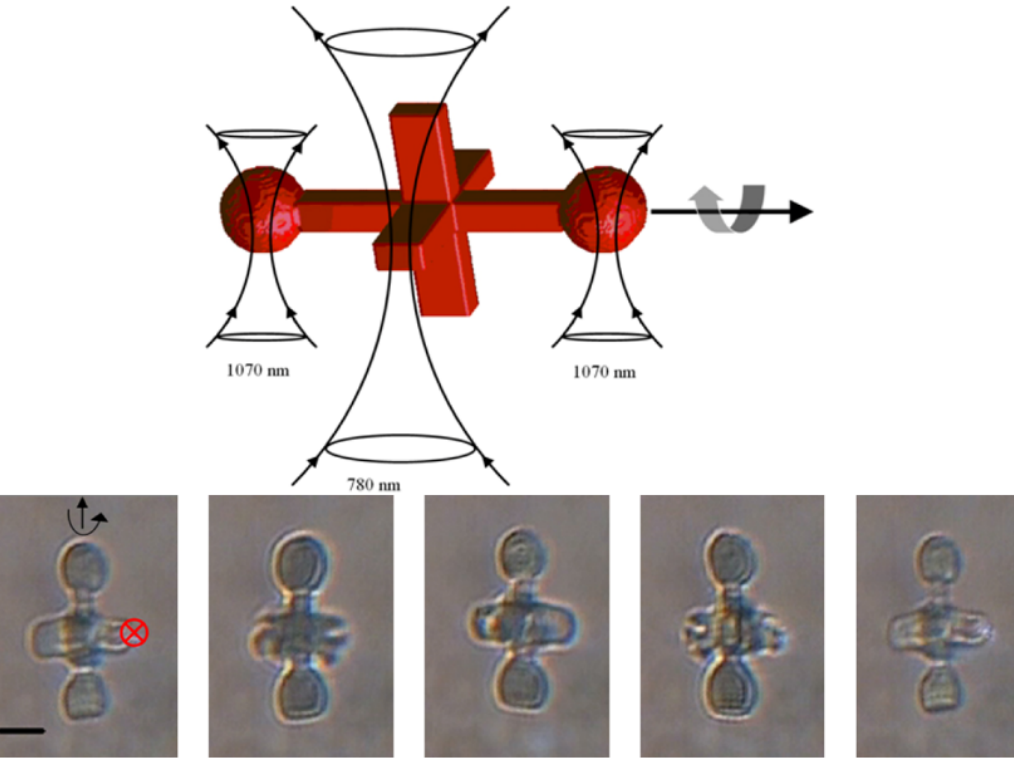
Figure 4. Asavei et al. produced an optical “paddle wheel” held in place using two 1070 nm optical traps and driven with a separate 780 nm beam. Reproduced from “Optically trapped and driven paddle-wheel”, [134], under Creative Commons license CC BY 3.0. ( Top ): Schematic of the device. ( Bottom ): Stills taken from a video of the device in action, where the position of the 780 nm beam is shown with a red